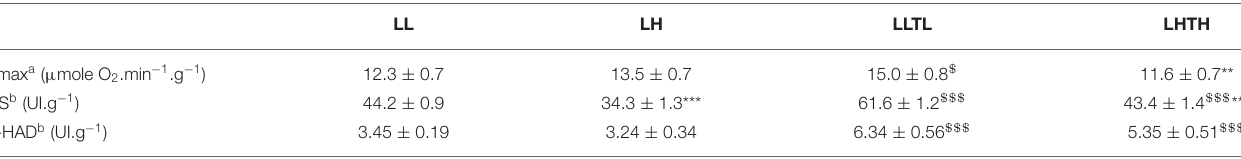
TABLE 3 | Biochemical plasma parameters at the end of the time-to-exhaustion test. LL LH LLTL LHTH Distance run (km)* 2.84 ± 0.40 4.38 ± 0.63 6.94 ± 0.51 $$$ 7.98 ± 0.57 $$$ Free Fatty Acid ( µ Mol.L − 1 ) 863 ± 167 1,146 ± 157 703 ± 101 811 ± 90 Glycaemia (mMol.L − 1 ) $ 7.52 ± 0.63 6.50 ± 0.69 7.18 ± 0.34 Lactate (mMol.L − 1 ) 2.37 ± 0.53 Data are expressed as the mean ± SEM. LL, normoxic and sedentary group; LH, hypoxic and sedentary group; LLTL, normoxic and trained group; LHTH, hypoxic and trained group. Statistically different from the normoxic group with the same level of activity, * P < 0.05. Statistically different from the sedentary group in the same environment, $ P < 0.05 and $$$ P < 0.001.